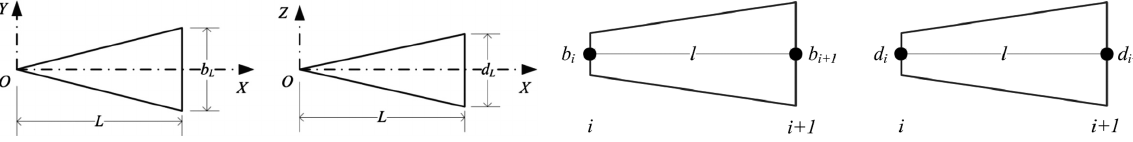
Fig. 3. Coordinate system of a complete wedge beam. Fig. 4. Schematic of a tapered beam element with varying width and